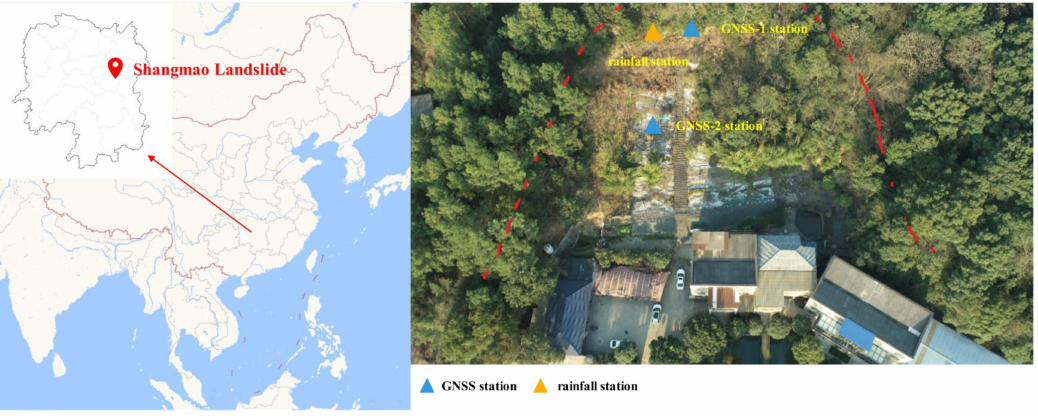
Figure 13. Location of the study area ( left ) and a photo of the Shangmao landslide ( right